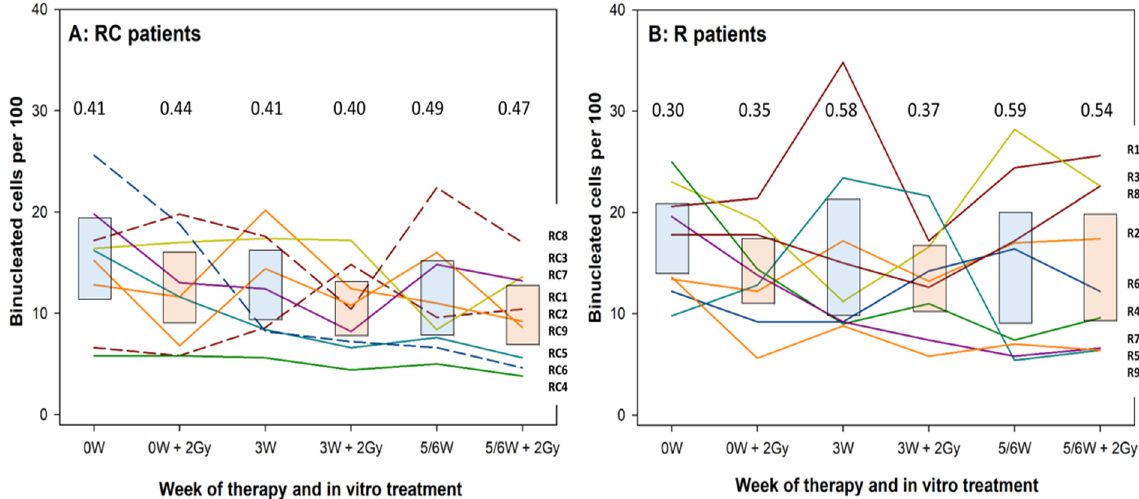
Figure 3. Individual values of cell proliferation marker in lymphocytes of RC ( A ) and R ( B ) patients. Each line represents a single donor. Lines are shown to facilitate identification of donors and not to represent a time response. Boxes show 95% confidence intervals of the respective mean value. Blue boxes: values induced by Therapy alone. Red boxes: values induce by therapy plus 2 Gy ex vivo irradiation. Dashed lines represent patients RC1, RC6 and RC8 who received colony stimulating factors (see Figure 1). 2 Gy designates samples irradiated under ex vivo conditions. Numbers above each treatment represent coefficients of variation. RC: patients receiving radiotherapy + chemotherapy; R: patients receiving radiotherapy alone; W: week of treatment. Patient numbers are given on the right Y axes in the order of the last treatment (5/6W + 2Gy).